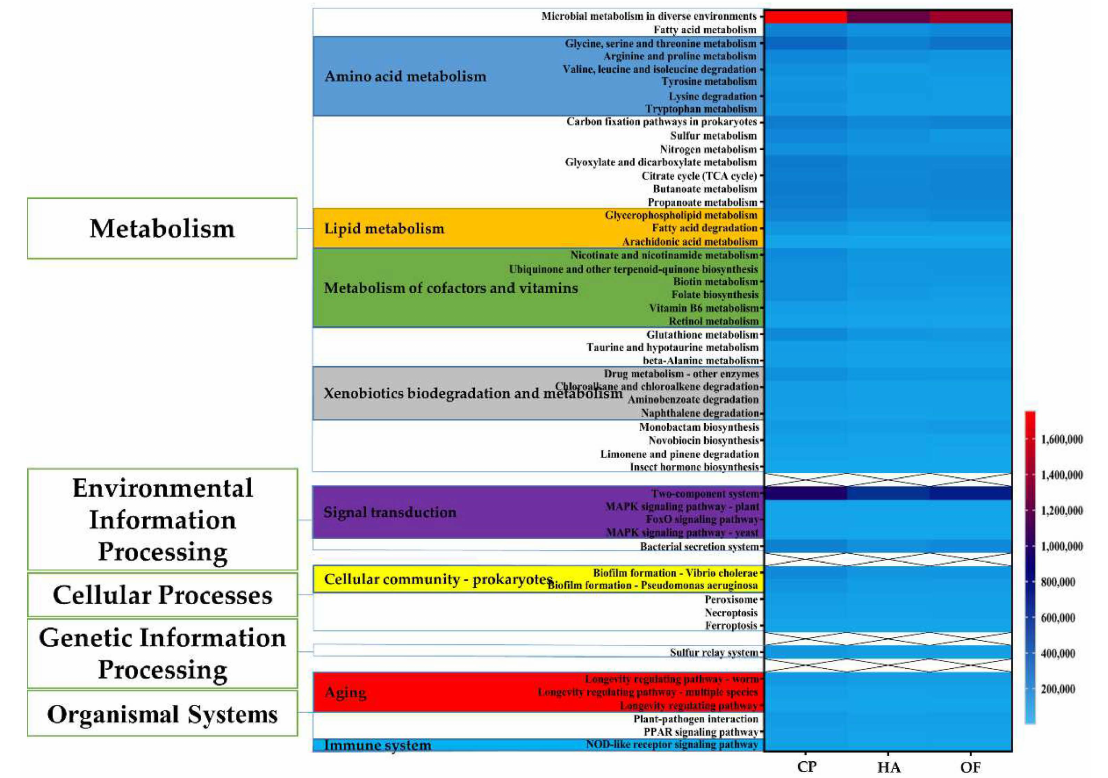
Figure 5. Comparison of KEGG pathway function prediction of intestinal microbial community. The left side is the pathway Level 1 function, and the middle is the pathway Level 2 function, while the right heatmap is the pathway Level 3 function. The pathway Level 2 function marked with various colors are all functions with significant differences, and the second-class function marked with different colors is also a function with significant differences. The scale on the right corner represents the abundance of the functions in each group. HA, H. armigera ; CP, C. punctiferalis ; OF, O. furnacalis